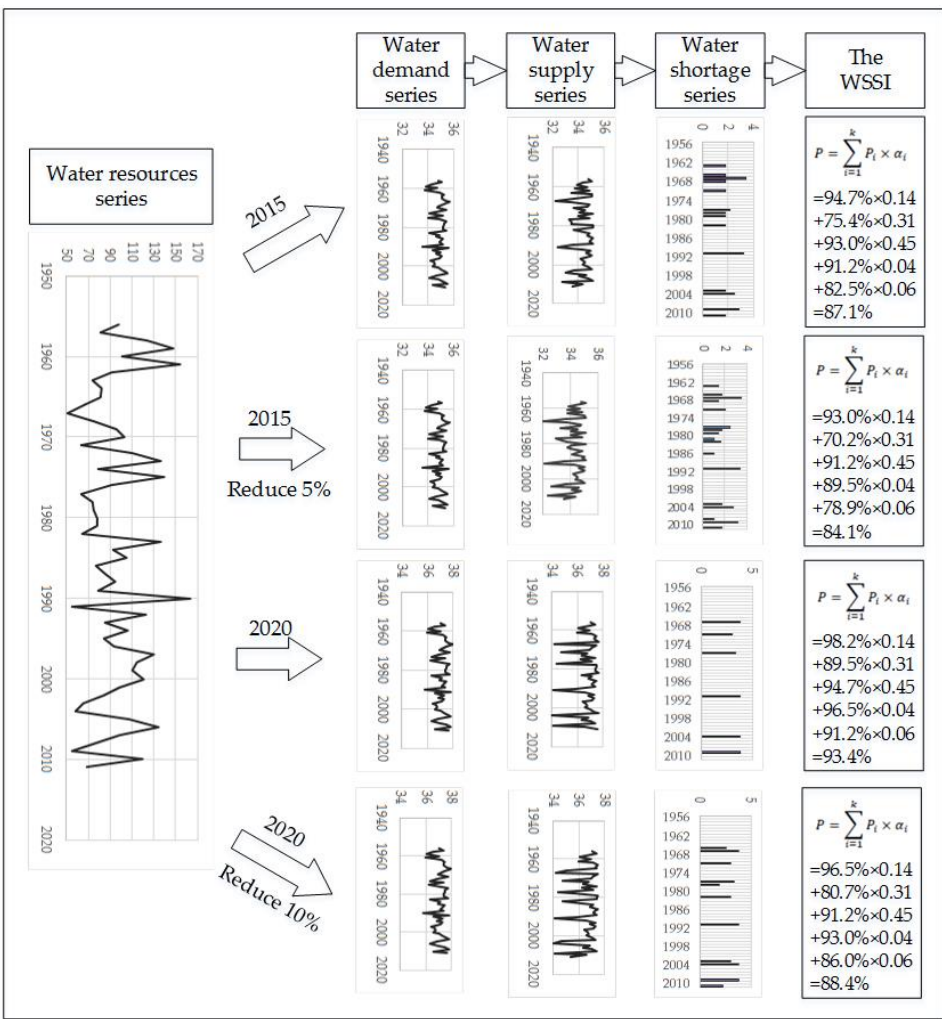
Figure 6. Allocation results and WSSI in Quanzhou. Note: The units for water resources, water